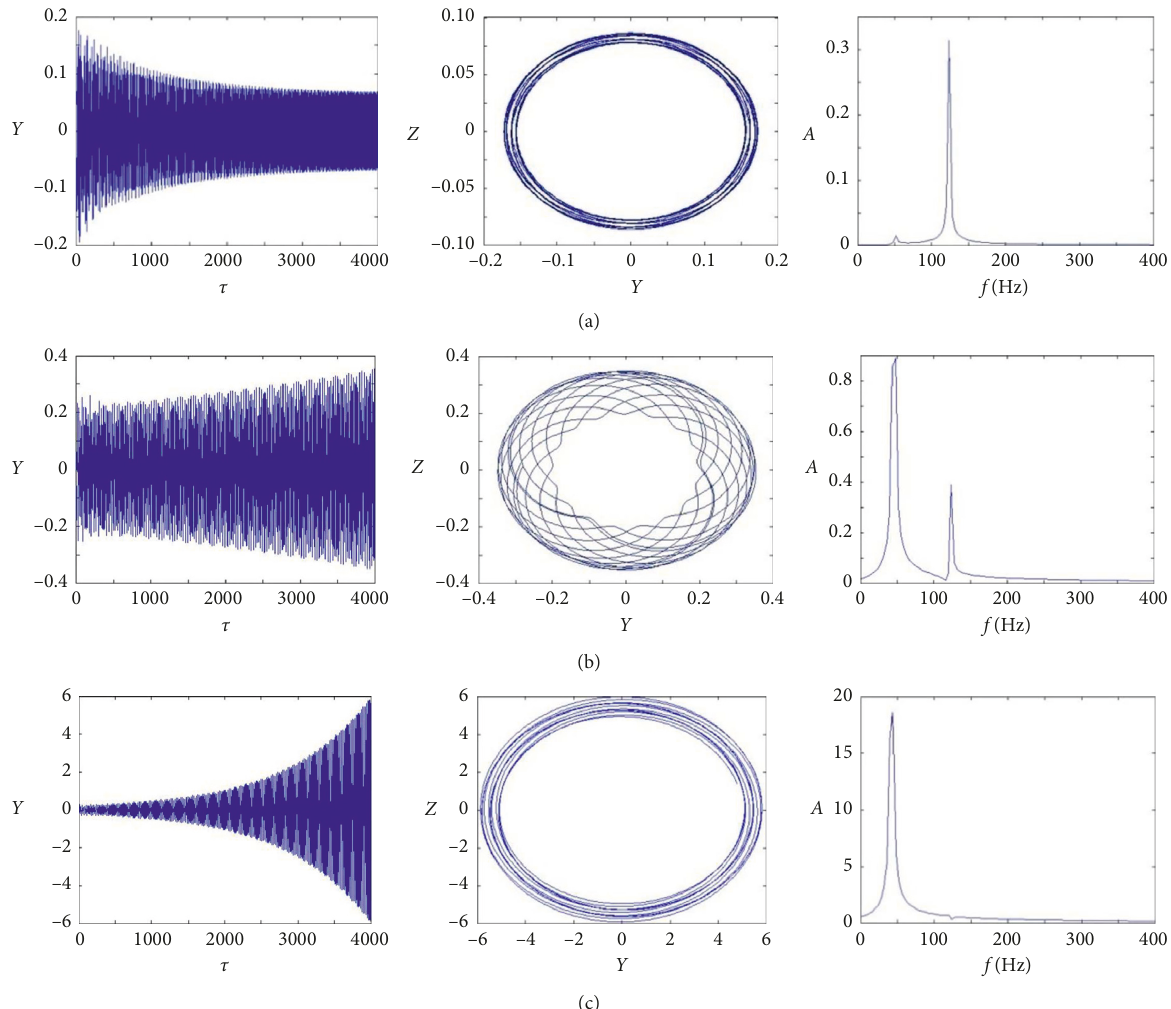
Figure 11: Rotor responses of time domain, axis orbit, and spectrum at different disk radii. (a) b